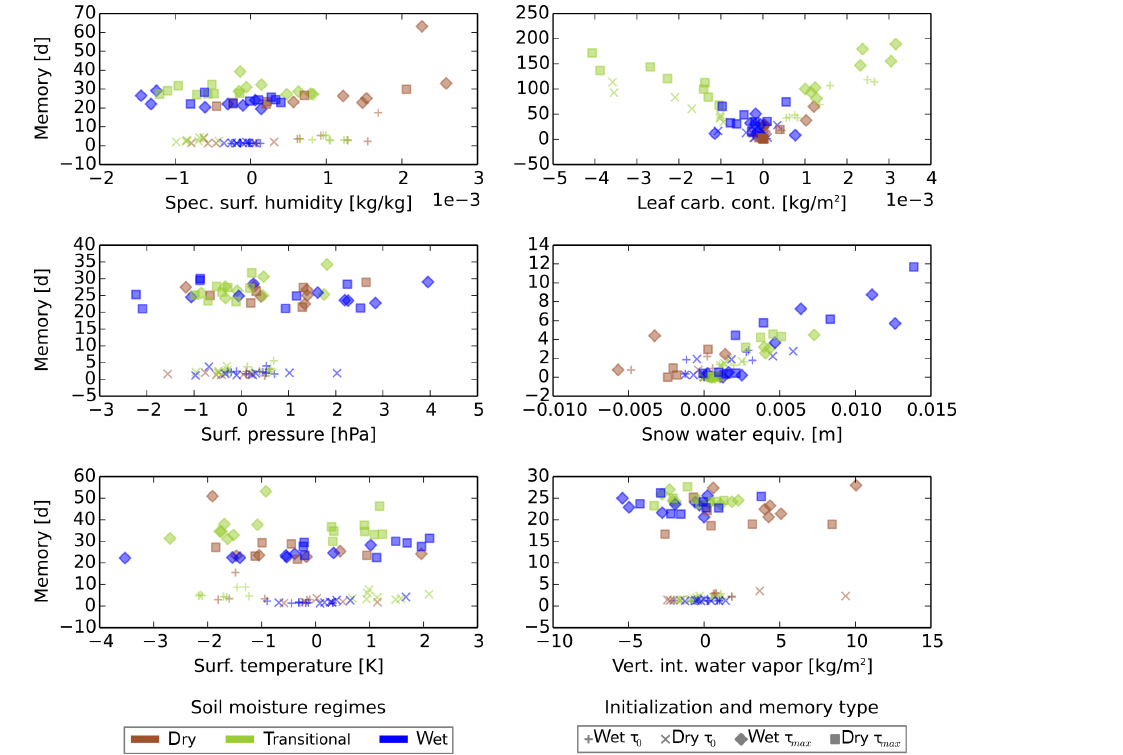
Figure 10. Scatter plots of induced anomaly–memory relation in surface states for all land surface grid cells. The colours indicate the soil moisture regime. The symbols refer to the soil moisture initialization state and the memory